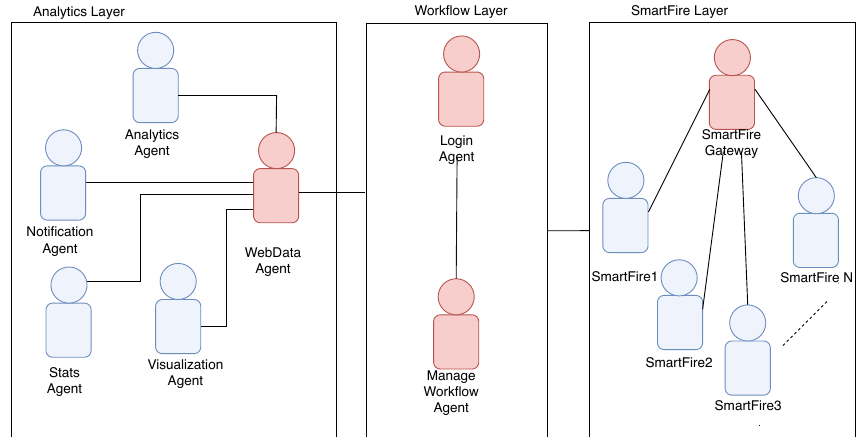
Figure 7. SmartFire platform diagram of the functional concept of the architecture.